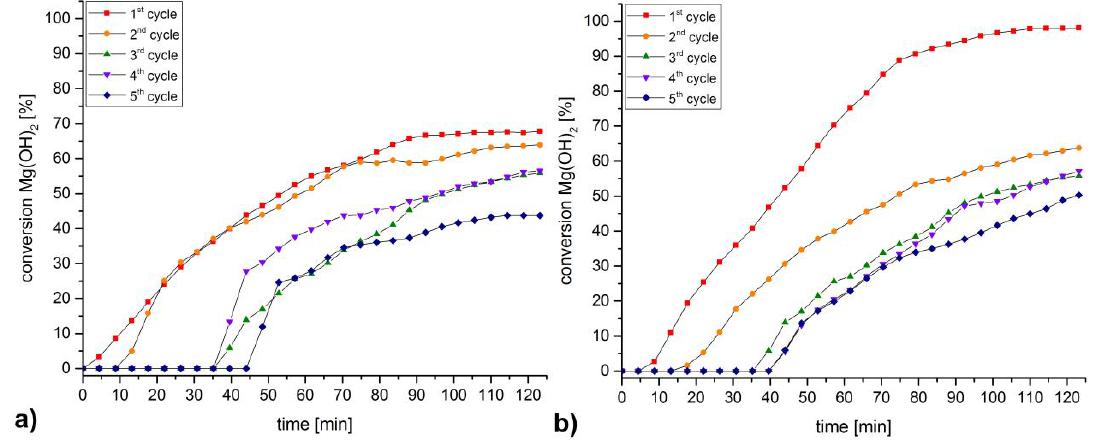
Figure 7. ( a ) Direct rehydration and cycle stability of MgC 2 O 4 -originating MgO C 2 O 4 -1 ; ( b ) Rehydration and cycle stability of MgC 2 O 4 -originating MgO C 2 O 4 -4.